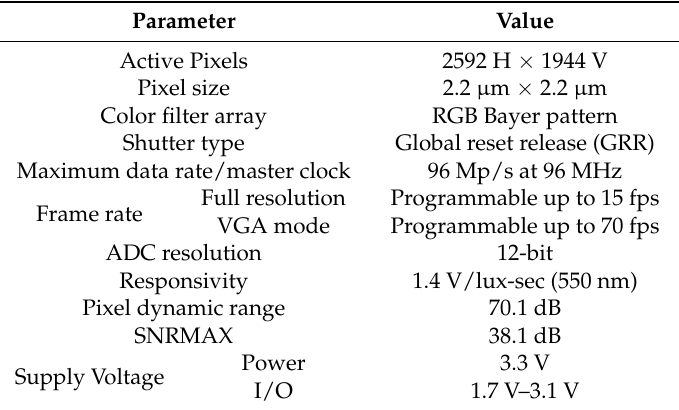
Table 1. Key performance parameters of the digital image